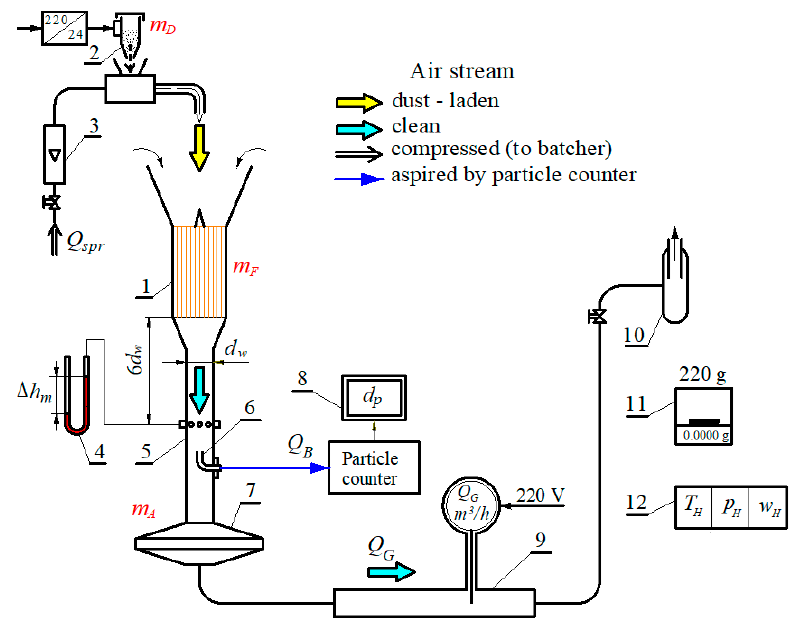
Figure 13. Diagram of the test stand for testing air filters of automotive engines: 1—filter cartridge, 2—dust dispenser, 3—rotameter, 4—U-tube type liquid pressure gauge for measuring pressure drop across the filter [mm H 2 O], 5—measuring tube, 6—measuring probe, 7—absolute filter, 8—measuring computer, 9—air flow meter, 10—suction fan, 11—analytical balance, 12—instrument for